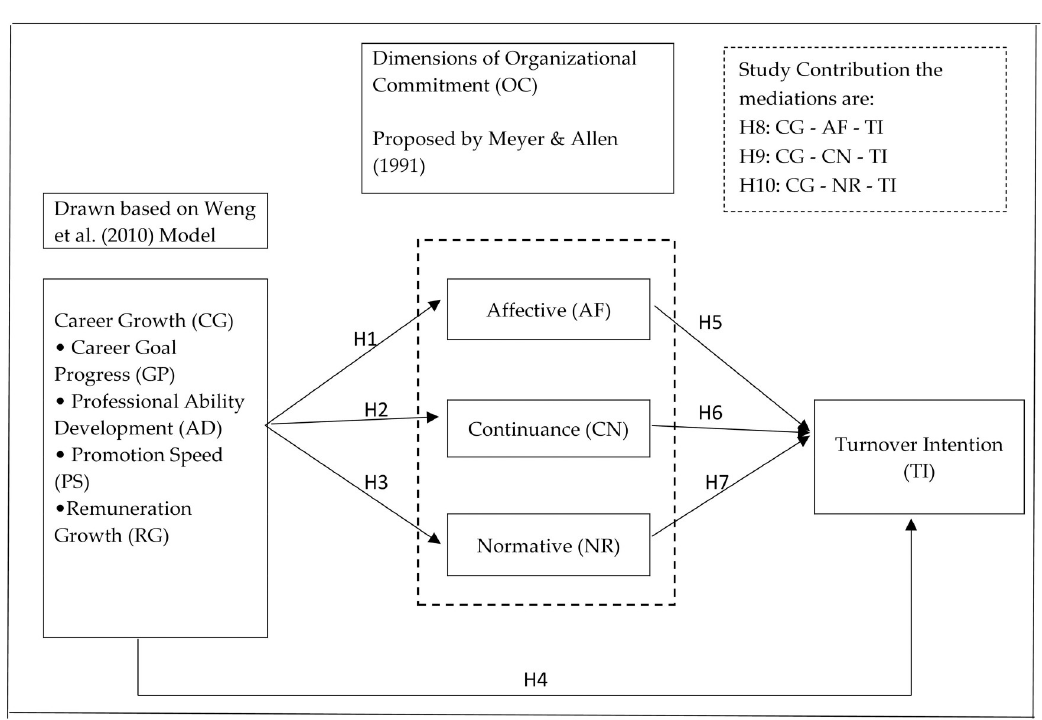
Fig 1. Proposed conceptual framework. Source: Authors’